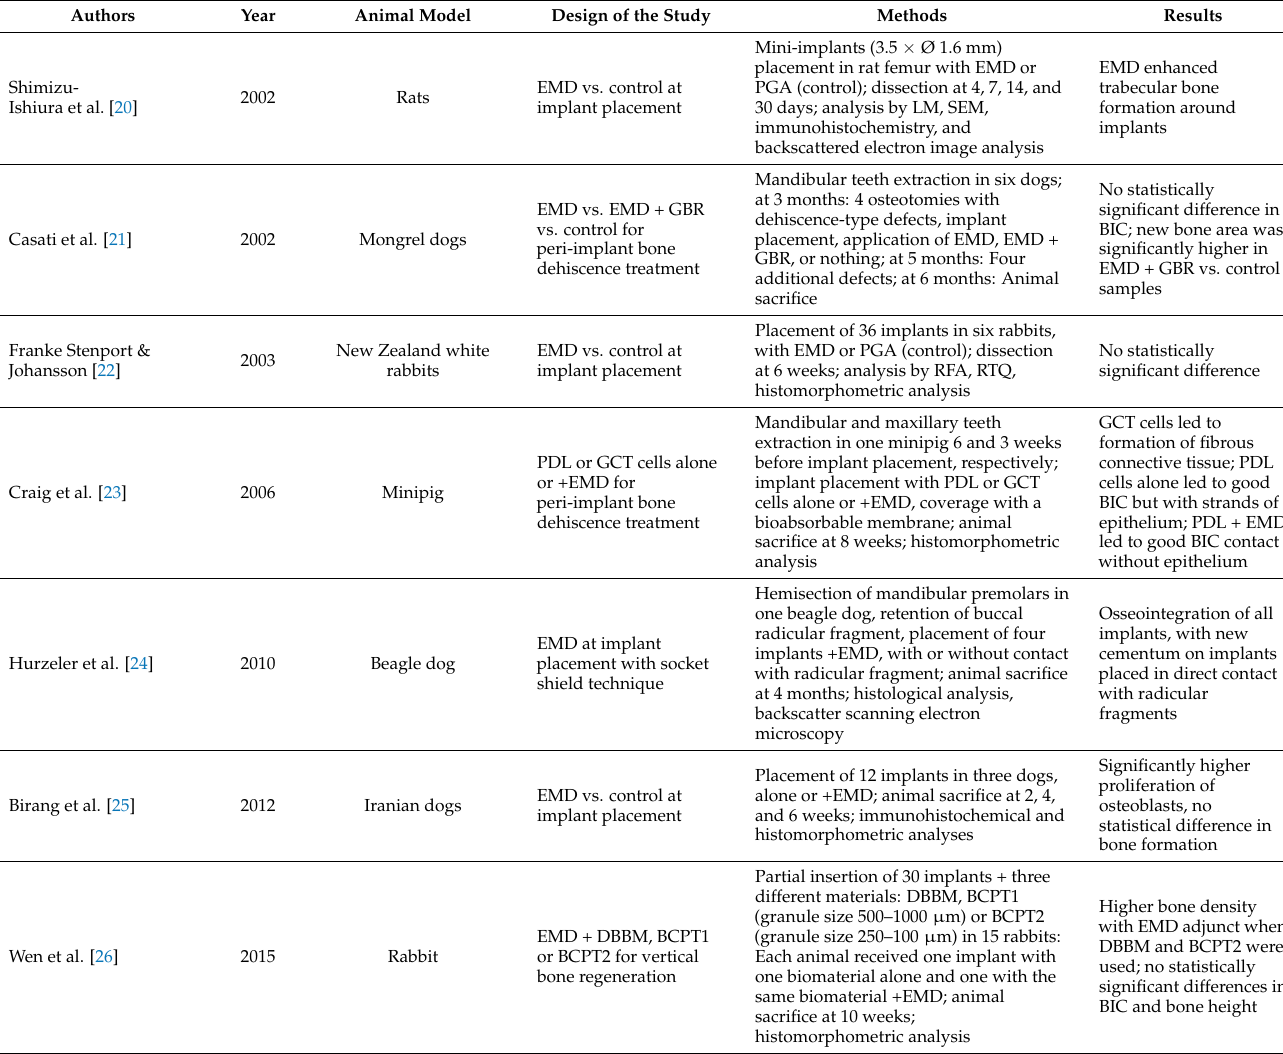
Table 2. In vivo studies on the effect of EMD on implants in animal